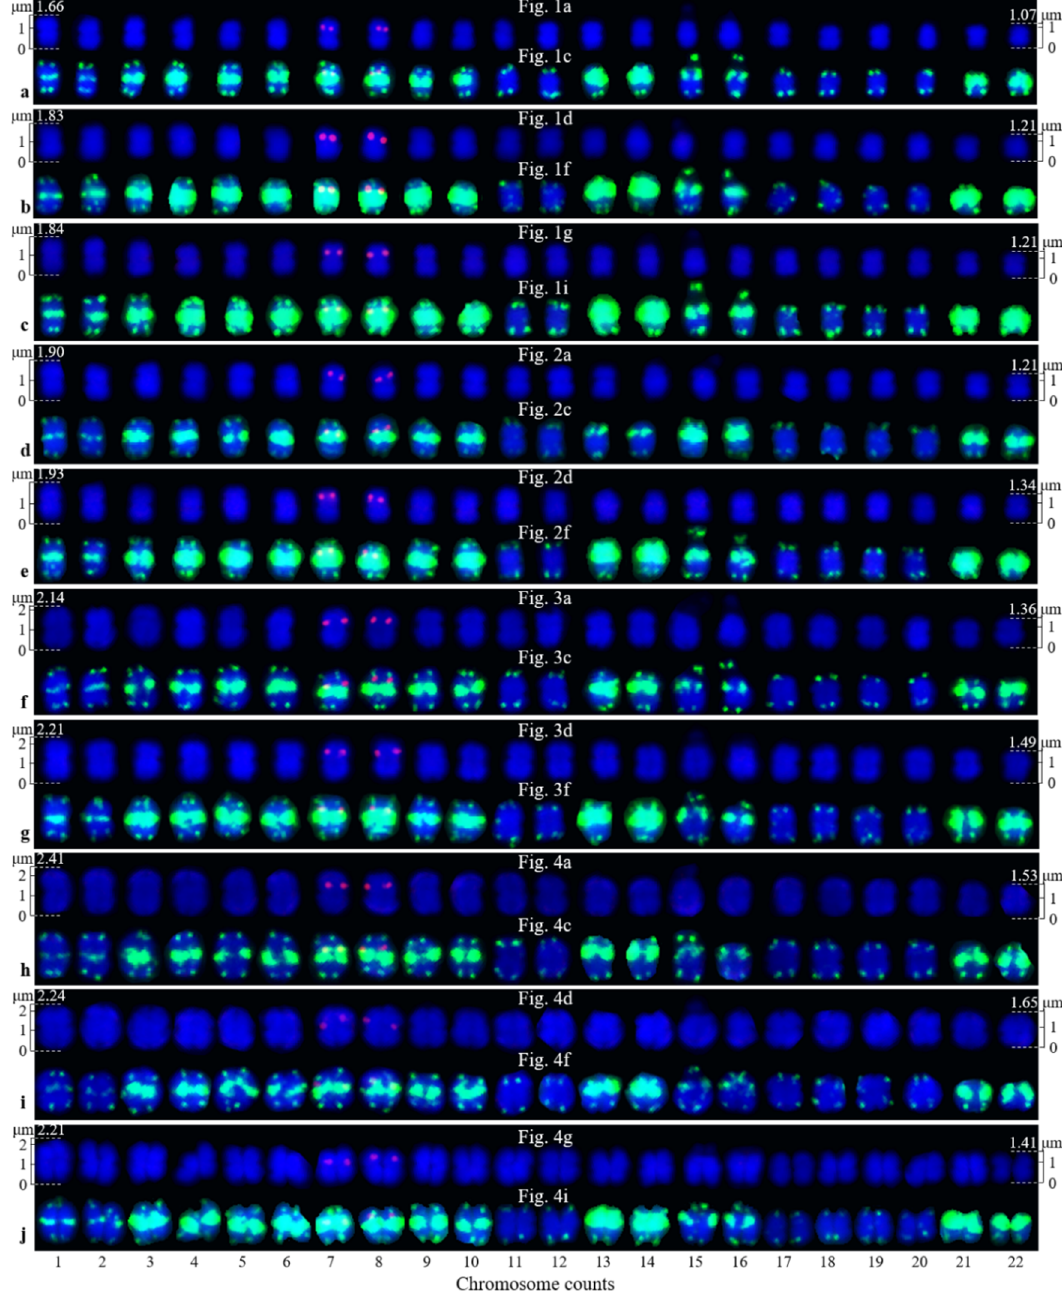
Figure 5. Each chromosome of Chimonanthus campanulatus isolated from Figures 1–4. For example, the chromosomes in Figure 5 a were isolated from Figures 1a and 1c, as indicated in the middle of each chromosome line. Because the (AG 3 T 3 ) 3 end signals likely a ff ect the measurement of chromosome length, only the first and last chromosomes in Figure 1a,d,g, Figure 2a,d, Figure 3a,d, Figure 4a,d,g were measured for total length. The chromosomes were aligned based on length. The bottom numbers indicate chromosome counts. The four split chromosomes in Figure 4g,i (yellow arrows) were assembled into two chromosomes (17 and 22) based on their signal patterns.